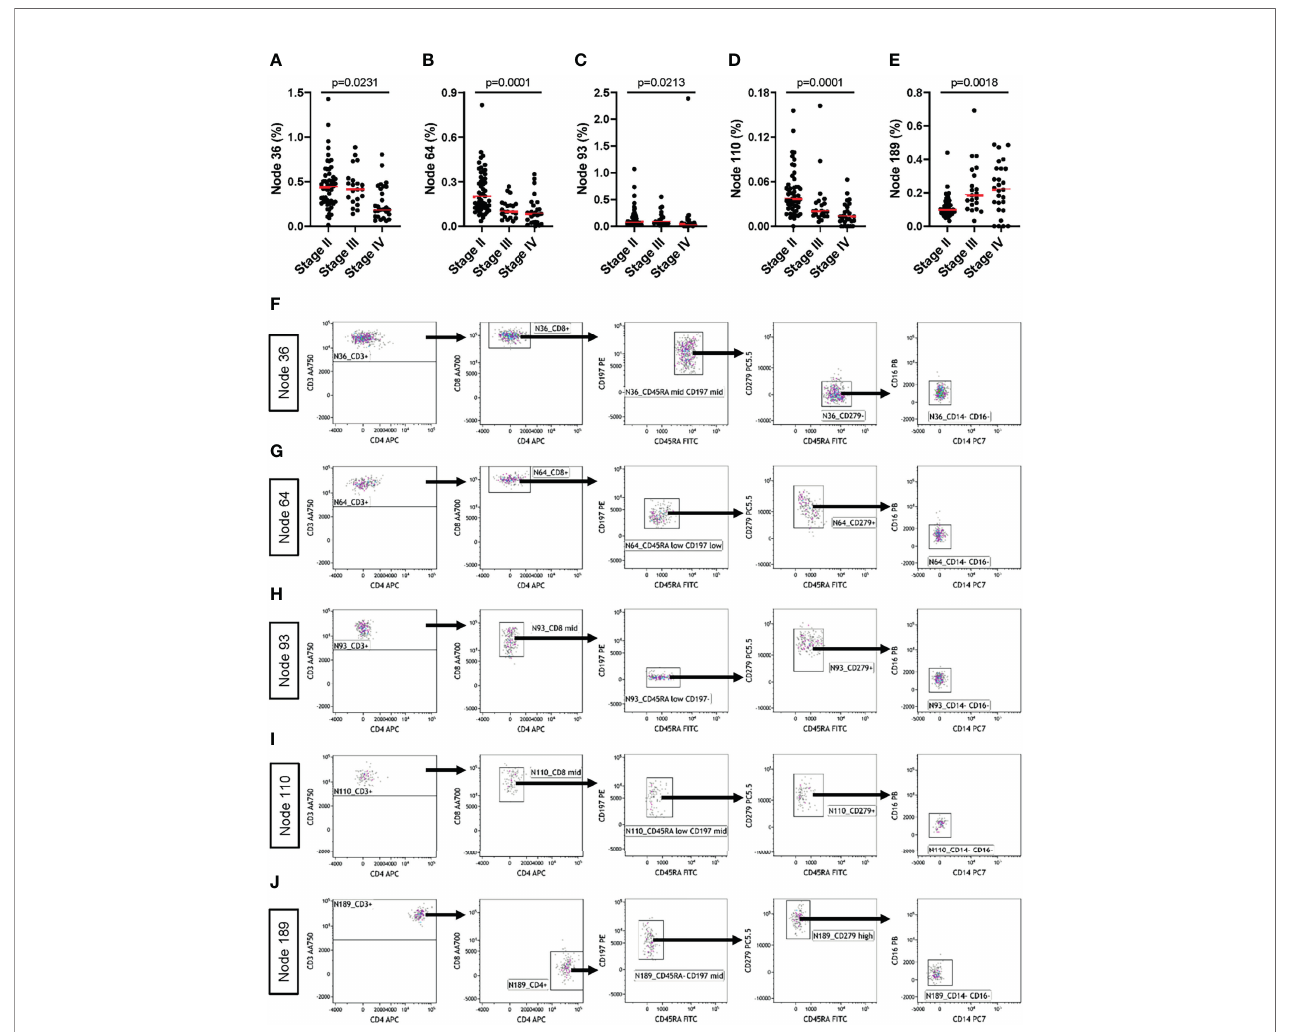
FIGURE 8 | The MoT test captures information about tumor staging. Fresh whole EDTA blood from patients with stage II (n = 52), stage III (n = 21) or stage IV (n = 27) melanoma were investigated using the MoT test. SPADE analysis of Lin - cells was performed in Cytobank with a density-dependent down-sampling target of 10% and a 200-cluster spanning tree. (A – E) Five clusters with signi fi cant stage-dependent differences were identi fi ed (K.W. test; B.H.-adjusted p-values, FDR = 5%). (F – J) All fi ve signi fi cant SPADE clusters were re-exported and analyzed as follows: gating on CD3 + T cells; gating on CD8 + or CD4 + T cells; gating on memory T cell subsets (CD45RA/CD197); gating on CD279 cells and gating on CD14 - /CD16 -